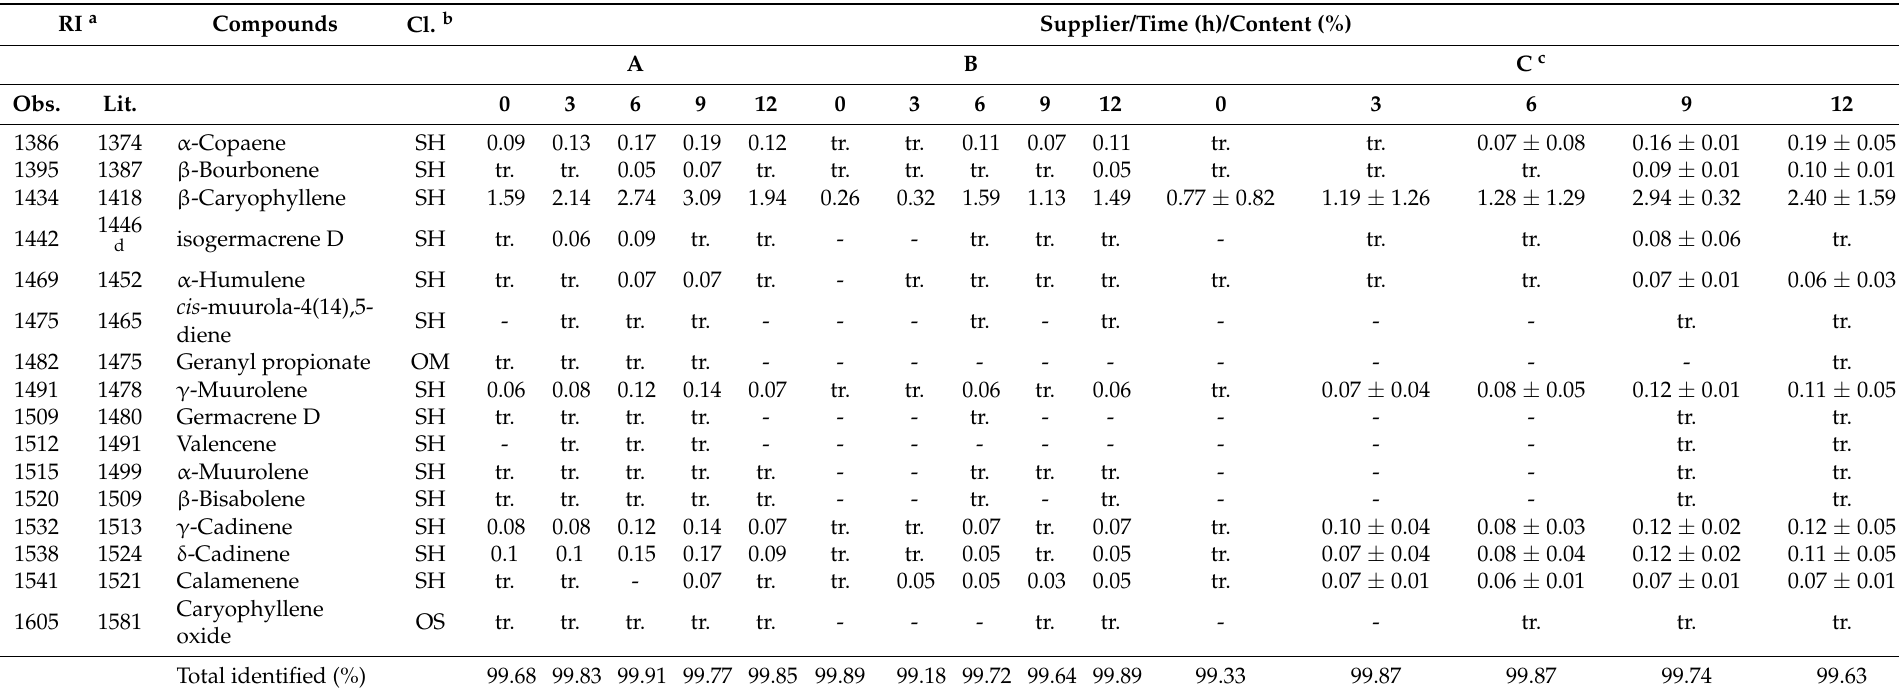
a RI = retention indices. Obs. = retention indices determined relative to a homologous series of n-alkanes (C8-C40) on an HP-5MS column. Lit. = literature Ri values [49,50]; b Cl = class; AH—aromatic hydrocarbon, MH—monoterpene hydrocarbon, OA—oxygenated aliphatic, OM—oxygenated monoterpene, OPM—oxygenated phenolic monoterpene, OPP—oxygenated phenylpropanoid, PM—phenolic monoterpene, OS—oxygenated sesquiterpene, SH—sesquiterpene hydrocarbon. c Relative peak area percentage as mean of three measurements ± standard deviation. d Literature RI values from [51]. e tr. = traces, relative peak area < 0.05%. f - = not